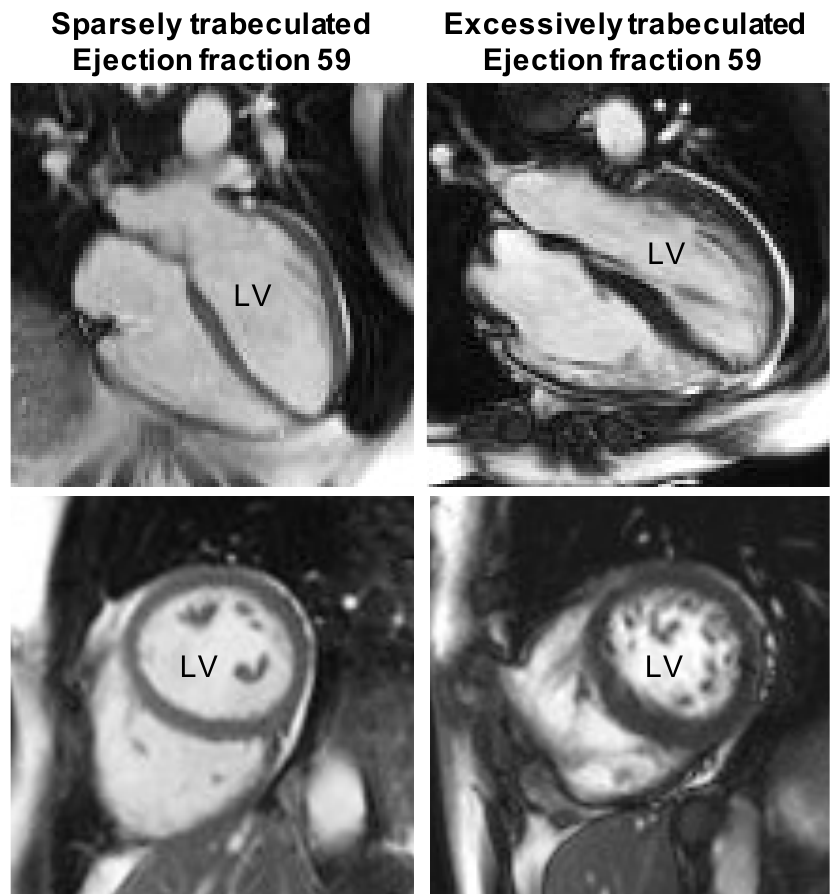
Figure 3. The architecture of the human left ventricle (LV) appears to have no impact on function. Normal ejection fractions (stroke volume/end-diastolic volume) occur in ‘Sparsely trabeculated’ and ‘Excessively trabeculated’ ventricles alike. The top row shows so-called four-chamber views and the bottom row shows transverse views of the two ventricles. Note the much more numerous and extensive trabeculations in the images on the right. Images from published data sets [45].